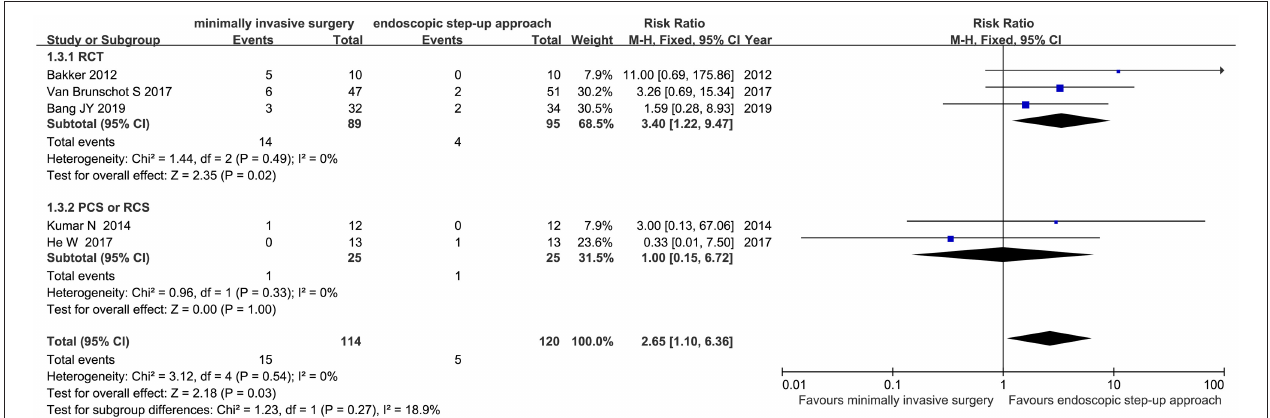
FIGURE 5 | Forest plots for the incidence of new-onset multiple organ failure in patients with minimally invasive surgery and endoscopic step-up approach. M-H, Mantel–Haenszel test; Fixed, a fixed effects model; CI, confidence intervals.